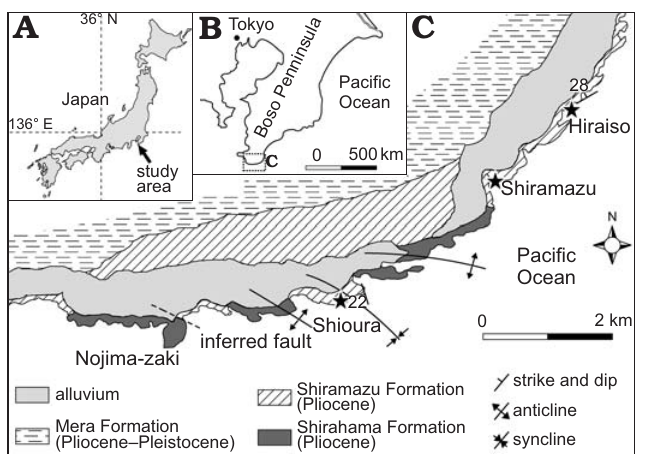
Fig. 1. A , B . Maps of Japan and Boso Peninsula illustrating the location of study area. C . Geological map of the southern coast of the Boso Peninsula, central Japan (modified after Kotake 1988, 1989; Izumi 2014). Fieldwork was carried out at the Hiraiso, Shioura, and Shiramazu sections (indicated by stars). Numbers in C indicate